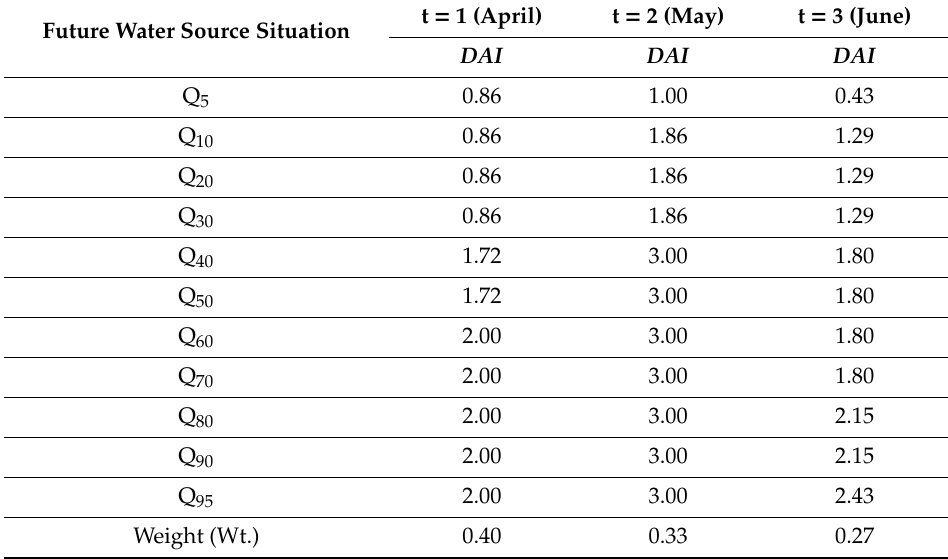
Table 15. Water supply analysis in the Irrigation Area in three future months from March 2013 (T = 3).